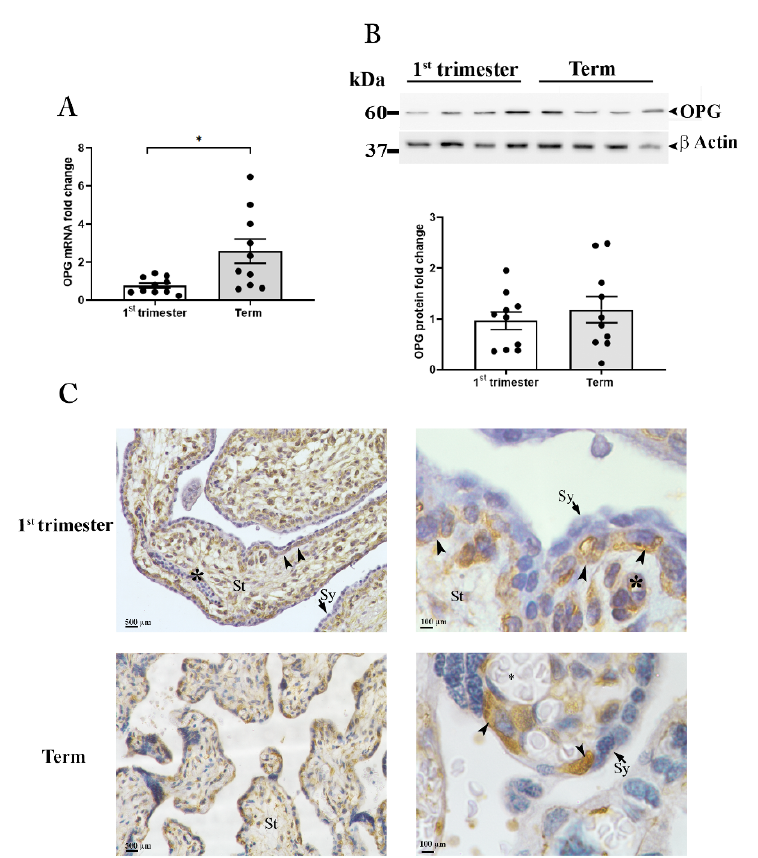
Figure 2. OPG expression in placental tissues. OPG mRNA expression ( A ) in placenta tissues at first-trimester (1st trimester; n = 10) and term ( n = 10) pregnancy. ( B ) Representative Western blot and relative OPG protein expression in first-trimester (1st Trimester; n = 10) and term (Term; n = 10) placenta tissues. β -actin was used as loading control. ( C ) Representative OPG immunolocalization in first-trimester (upper panels) and term placenta tissues (lower panels) ( n = 3 for each gestational period); villous stroma (St), perivascular cells of fetal capillaries (asterisk), cytotrophoblasts (arrow- head), syncytiotrophoblast (Sy, arrows). Data are presented as individual values, mean ± SEM are shown. Significance was determined with the unpaired t-test. * p < 0.05 .